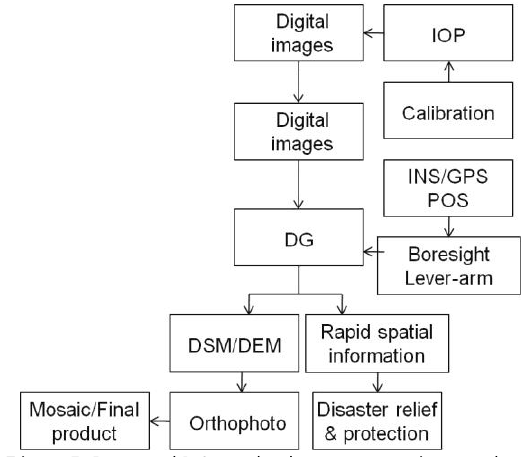
Figure 5. Proposed DG-ready photogrammetric procedure Integrated POS data processing